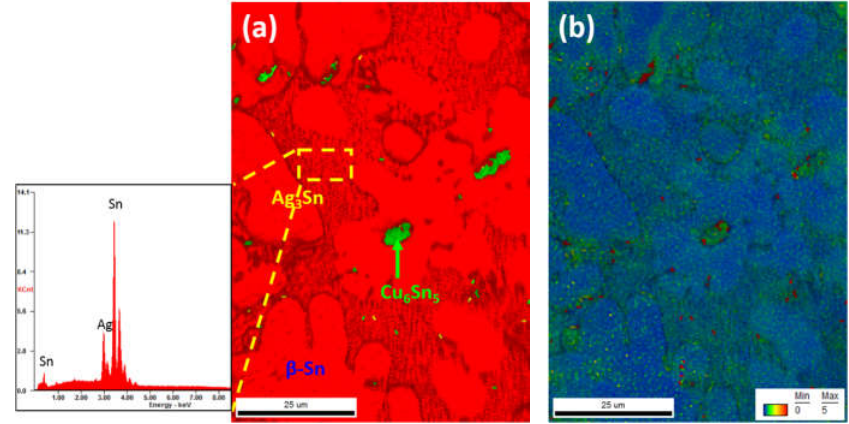
Figure 7. EBSD images of SAC305 before the creep test: ( a ) inverse pole figure (IPF); ( b ) kernel average misorientation (KAM).